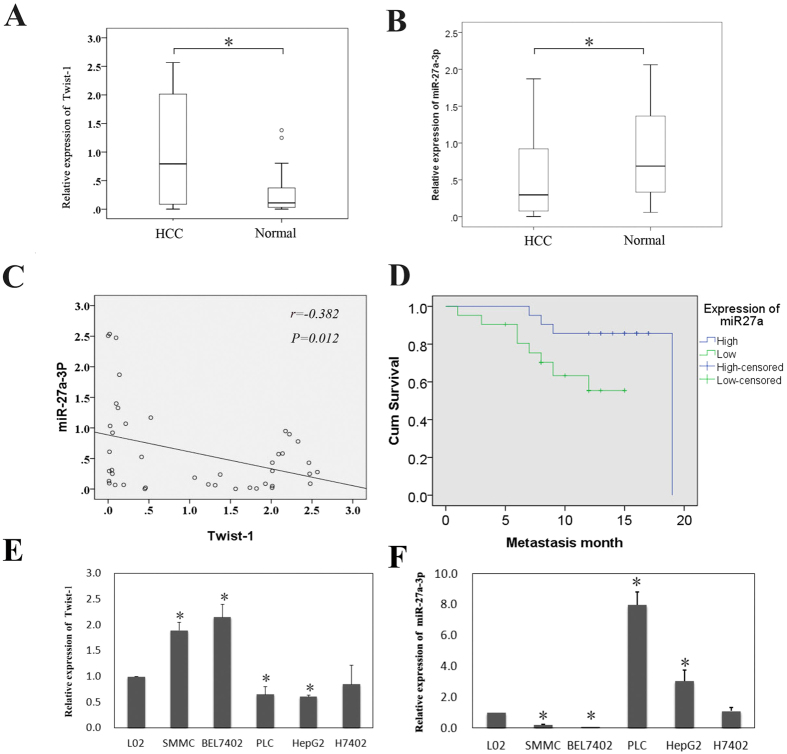
Relationship between miR-27a-3p and Twist-1 expression in HCC tissues and cell lines.(A) A box-and-whiskers plot showed that Twist-1 expression in HCC tissues was significantly higher than that in noncancerous tissues (*p < 0.05). (B) The box-and-whiskers plot directly showed that miR-27a-3p expression was significantly lower in HCC tissues than in noncancerous tissues (*p < 0.05). (C) Pearson correlation analysis showed that miR-27a-3p expression inversely correlated with Twist-1 expression in 42 HCC samples. (D) Kaplan-Meier survival curves of patients with HCC indicated that low miR-27a-3p expression was significantly associated with early metastasis of HCC. (E) Twist-1 expression in various HCC cell lines (*p < 0.05). (F) miR-27a-3p expression in various HCC cell lines (*p < 0.05).